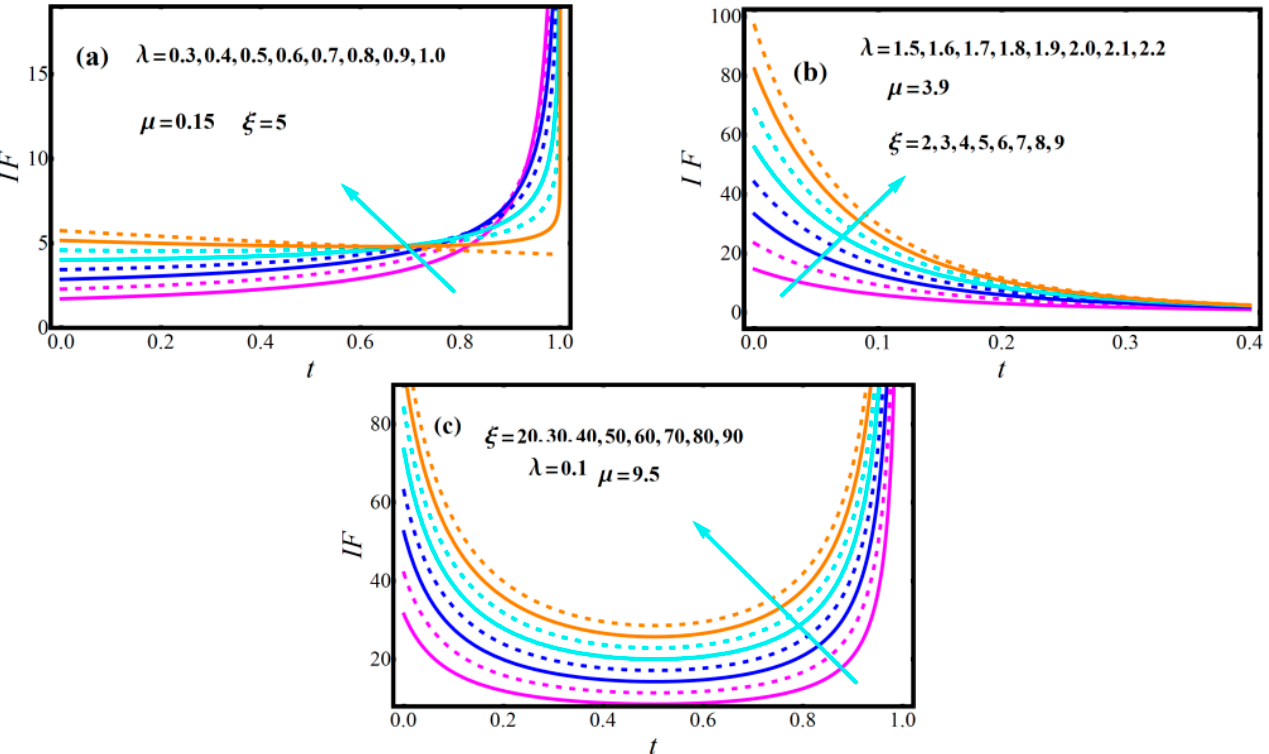
Figure 1. Visualization of the MVF of the NHPP–NPF model.